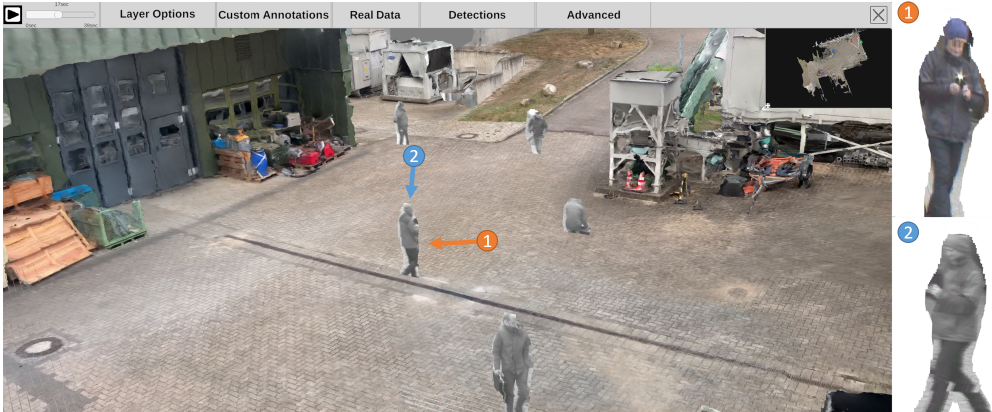
Figure 23. Dynamic point clouds displayed in the static scene from the current perspective ( Left ). If one navigates through space, the perspective changes and point clouds generated from different cameras can be perceived. For example, (1) the ( top right ) point cloud snippet can be seen from the direction indicated by (1) the orange camera and (2) the ( bottom right ) one from the direction indicated by the blue camera.